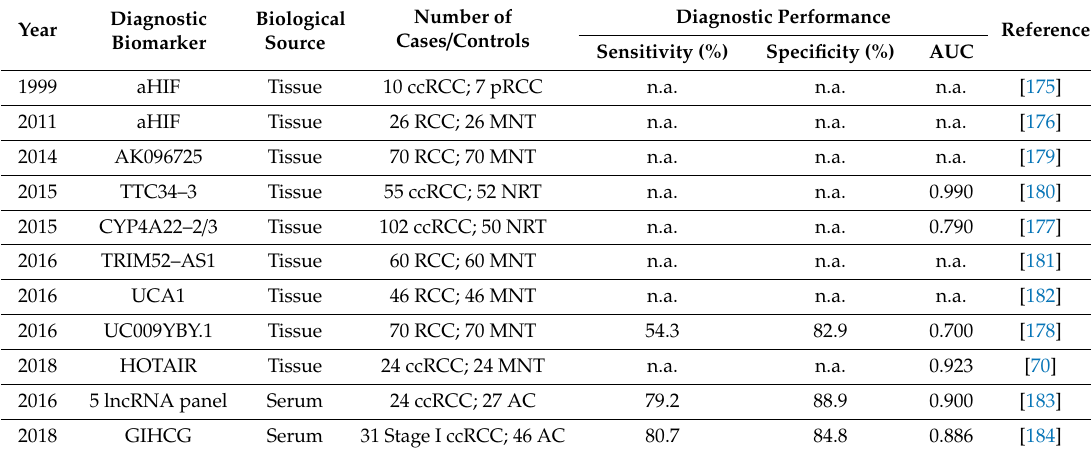
Table 6. Long non-coding RNAs (LncRNAs) as potential diagnostic biomarkers in RCC tissues and liquid